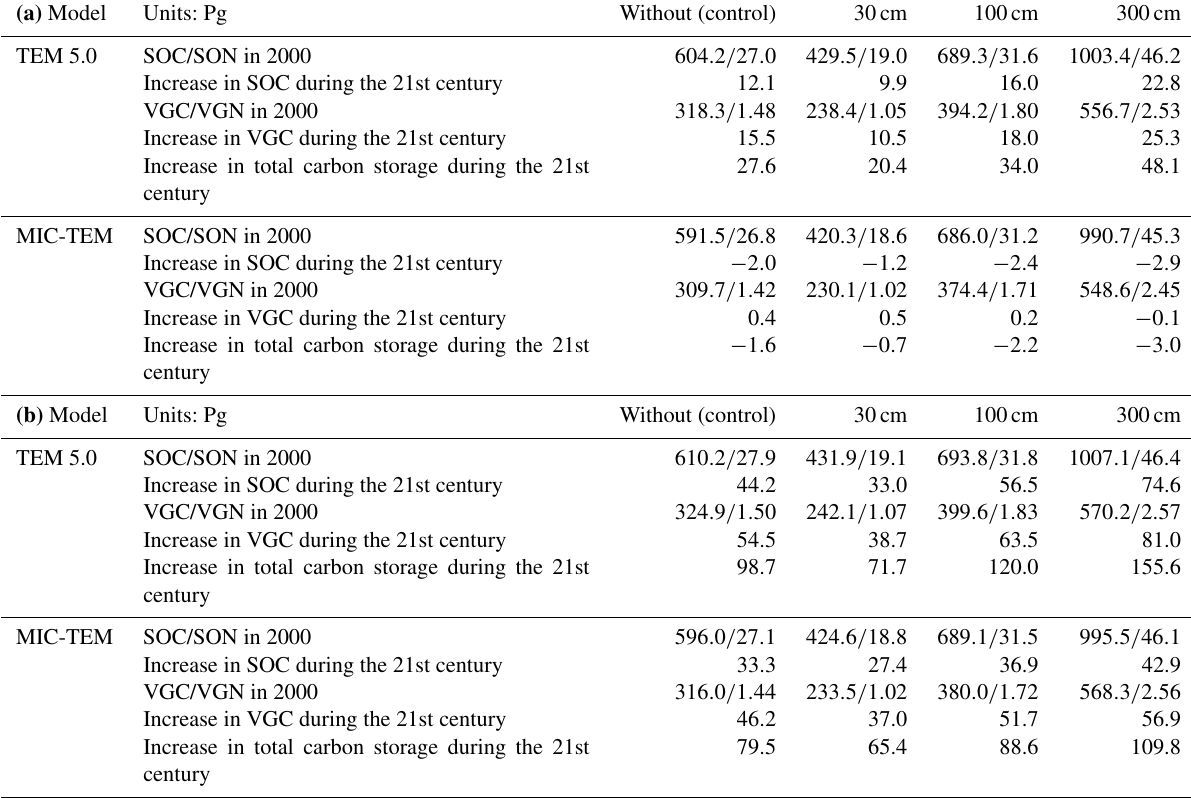
Table 3. Increasing of SOC, vegetation carbon (VGC), soil organic nitrogen (SON), vegetation nitrogen (VGN) from 1900 to 2000, and total carbon storage during the 21st century predicted by two models with observed soil carbon data of three different depths under (a) RCP 2.6 and (b) RCP